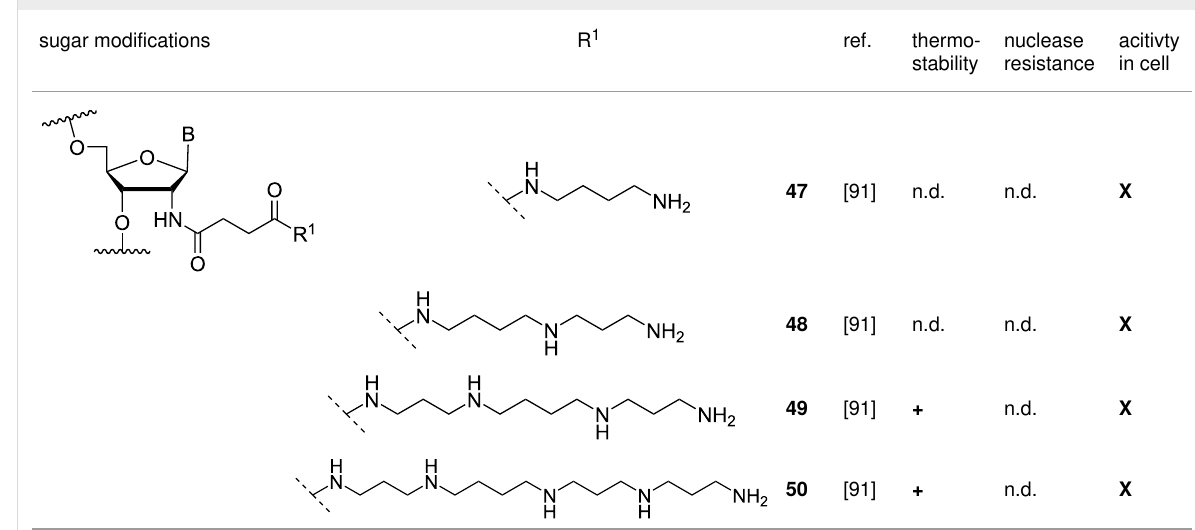
Table 5: Amine-functionalized groups attached to the sugar scaffold. a